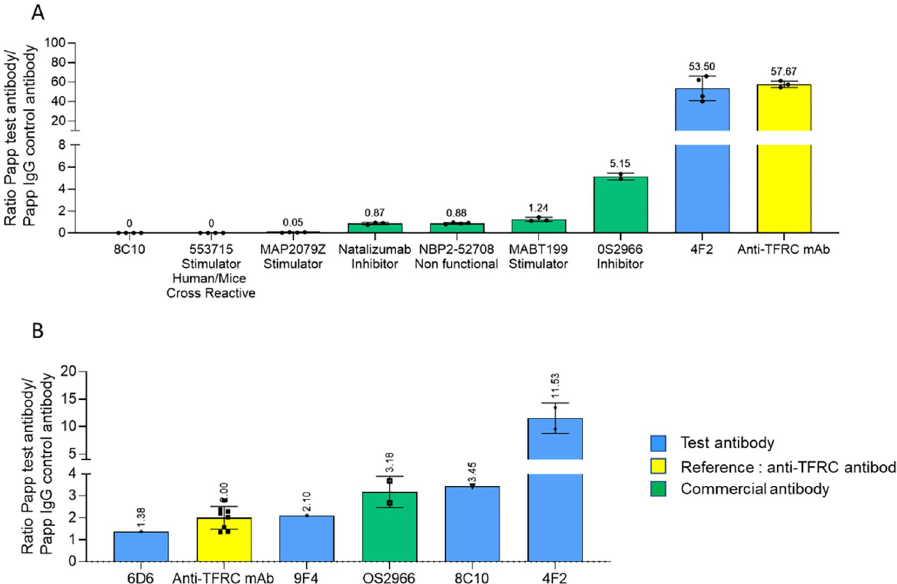
Fig 3. Antibody transport in two commercial in vitro BBB models. (A) Transcytosis in the PharmaCo-Cell 1 Transwell 1 model. (B) Transcytosis in the Brainplotting ™ Transwell 1 model. Results are given as P app test antibody/ P app control antibody. Blue bars represent test antibodies, the green bar represents a commercial antibody, and the yellow bar represents the reference anti-TFRC antibody. Each point represents one Transwell 1 .